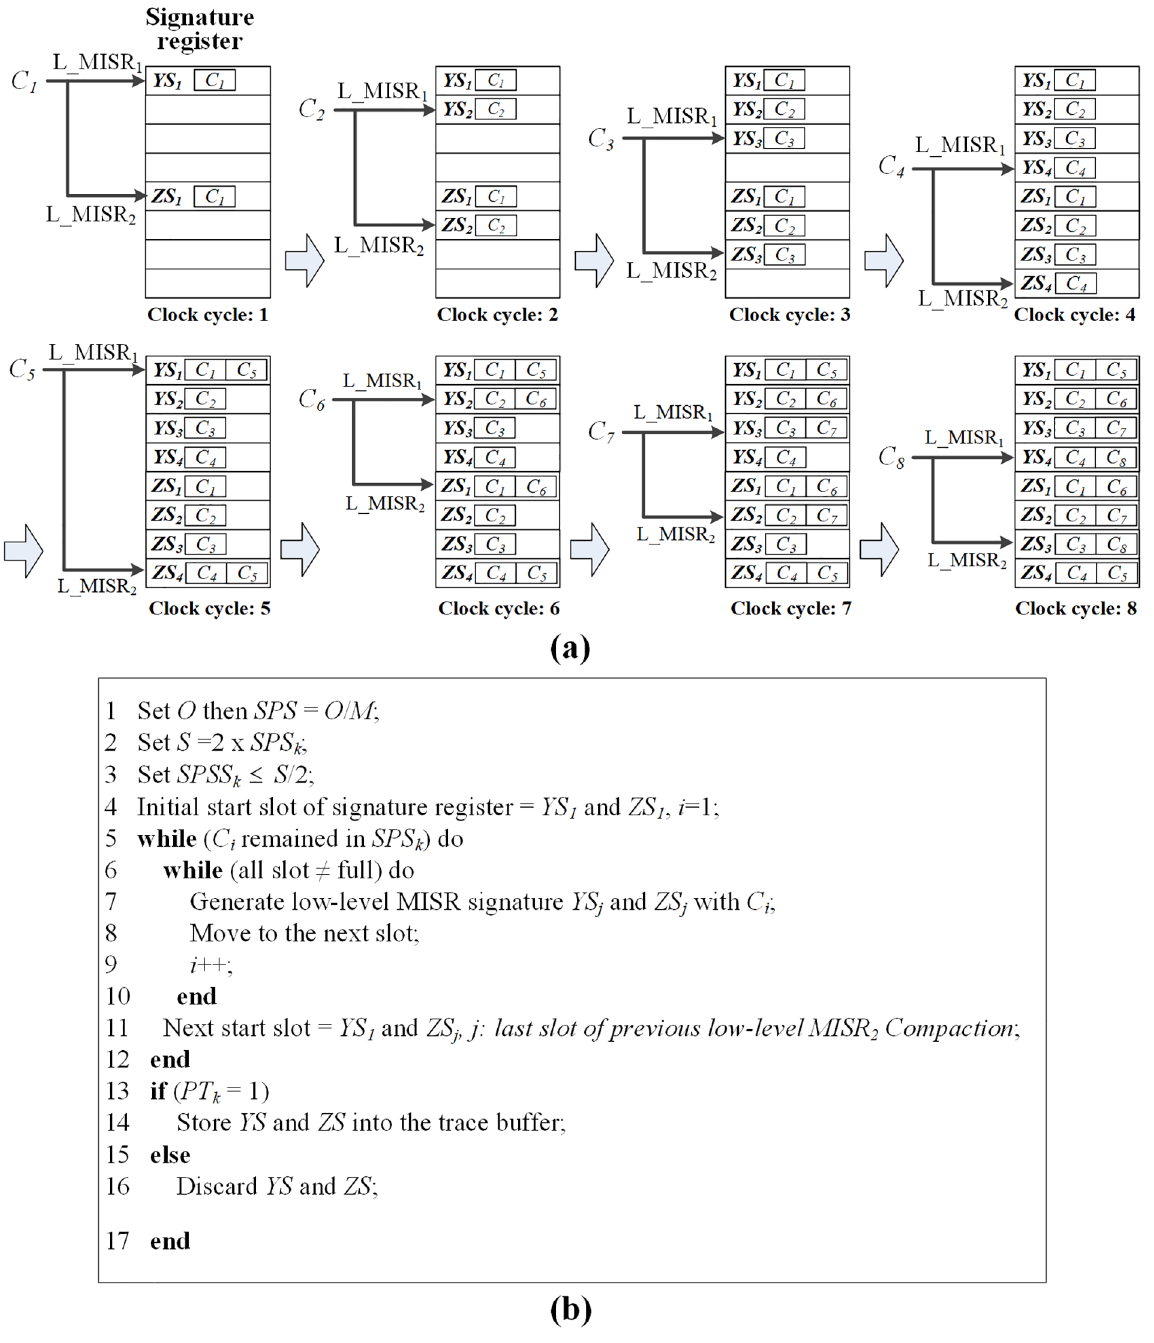
Fig 4. Low-level MISR operation to analyze error-suspect debug cycles: (a) temporary signature register usage for compaction of low-level MISRs; (b) algorithm for the operation of low-level MISRs and the signature register.